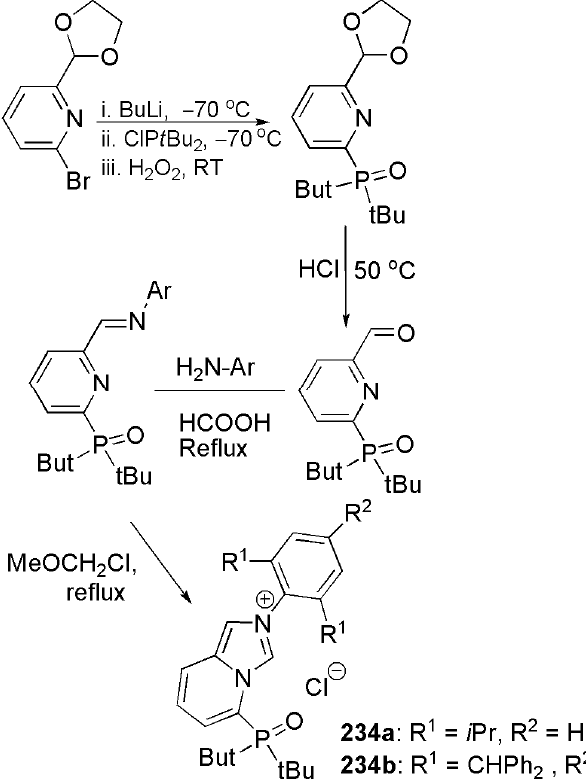
Figure 29. Design strategy for NHC ‐ oxygen ligand [208]. As depicted in Scheme 56, ortho ‐ lithiation of 2 ‐ bromo ‐ 6 ‐ (1,3 ‐ dioxolan ‐ 2 ‐ yl)pyridine and subsequent nucleophilic attack of carbanion on di ‐ tert ‐ butylphosphinic chloride introduces di ‐ tert ‐ butylphosphine oxide group. Subsequent deprotonation, Schiff base condensation and cyclization with methoxymethyl chloride yielded the desired rigid imidazolium salts 234a and 234b with a side phosphine oxide group as a weak sigma donor site [208].